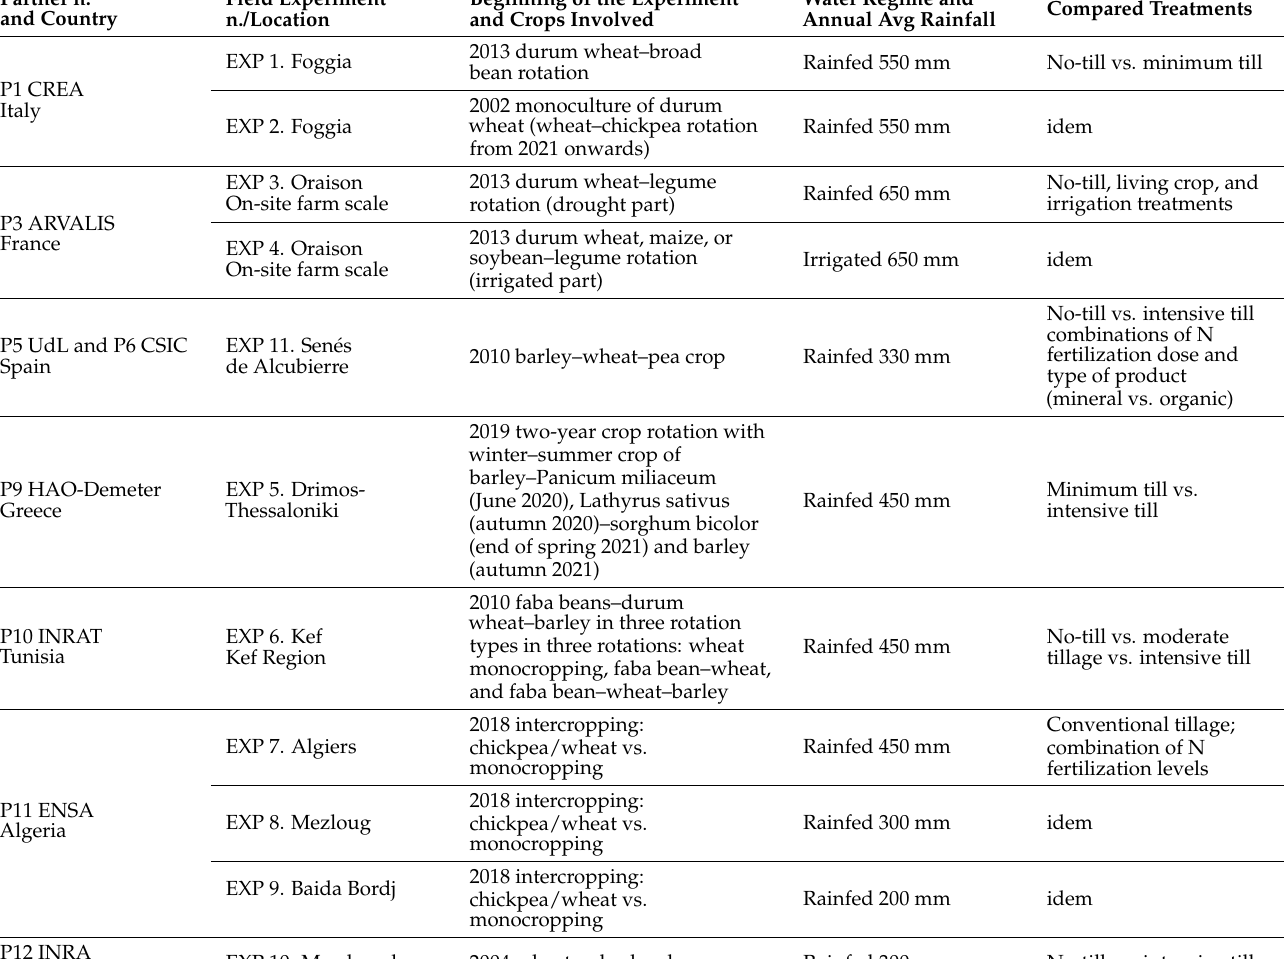
Table 4. Experimental network of the CAMA